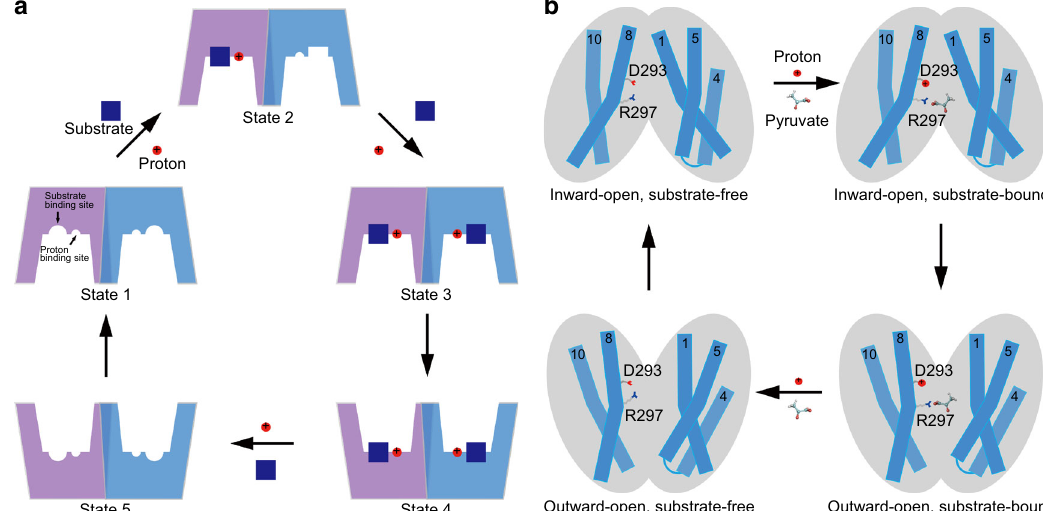
Fig. 5 Proposed working models depicting the transport mechanism of MCT2. a Proposed cooperative transport mechanism of MCT2. Shown here are the allosteric MCT2 dimer in fi ve different states: inward-open, low af fi nity, substrate-free state (state 1), inward-open, high af fi nity state with substrate- bound only in a subunit (state 2), inward-open, high af fi nity state with substrate-bound (state 3), outward-open, high af fi nity state with substrate-bound (state 4), outward-open, low af fi nity, substrate-free state (state 5). The details of the models are discussed in the main text. b Proposed monocarboxylate/ H + symport mechanism of MCT2. Shown here are the predicted conformations of MCT2 subunit: inward-open, substrate-free and -bound, and outward- open, substrate-bound and -free, required for a complete transport cycle according to the alternating access model. The inward-open substrate-free conformation of MCT2 is reported in this